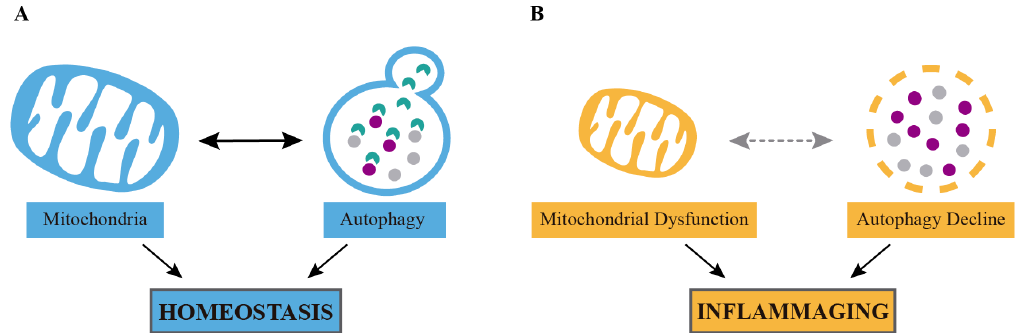
Figure 1. Mitochondria and autophagy interplay during inflammation and aging. ( A ) Mitochondria metabolism and autophagy are two of the most metabolically active cellular pathways, both plying critical roles in the regulation of the metabolic health and the organism homeostasis. ( B ) However, the impairment of the mitochondrial function, the autophagy pathway, or its crosstalk lead to inflammation and aging.